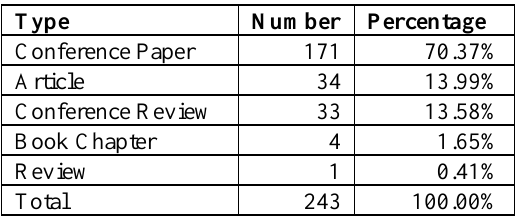
Table 2. Distribution of publications by type